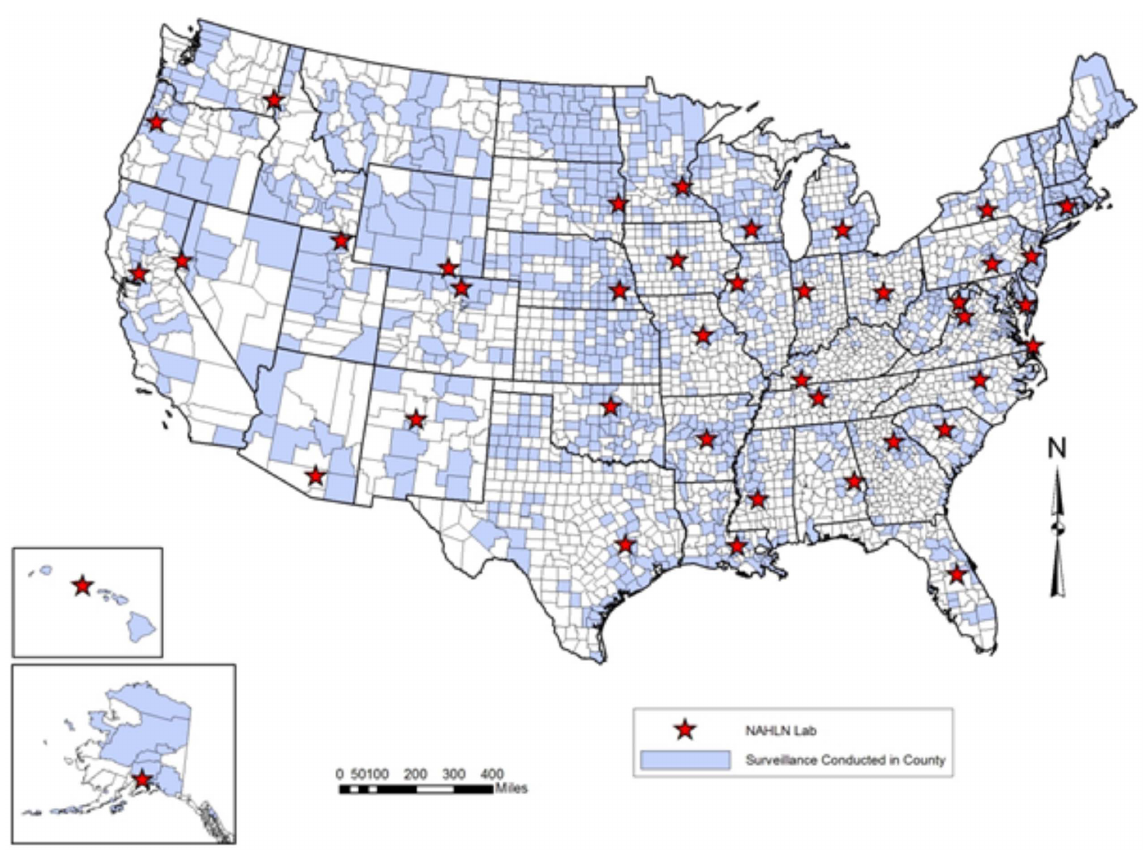
Figure 1. Hunter-harvested and live wild birds were sampled for avian influenza virus throughout the USA. Samples were collected in shaded counties and testing occurred at starred NALHN laboratory locations.